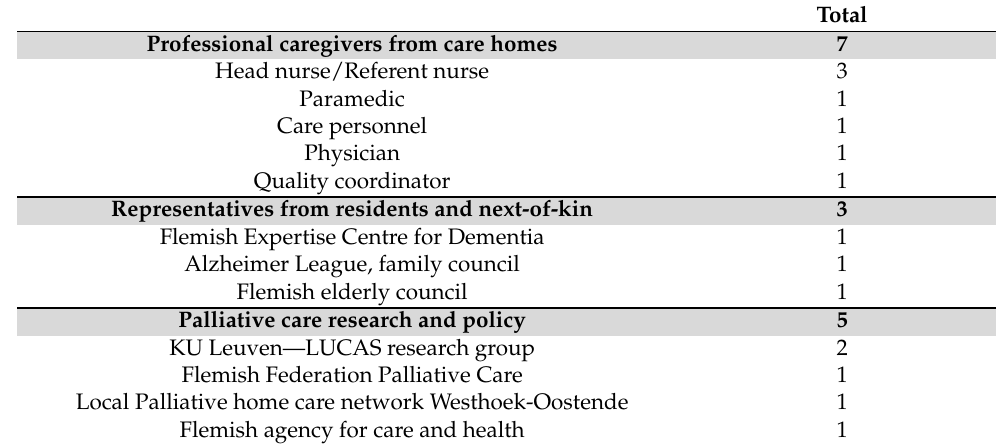
Table 3. Participants in expert consultation